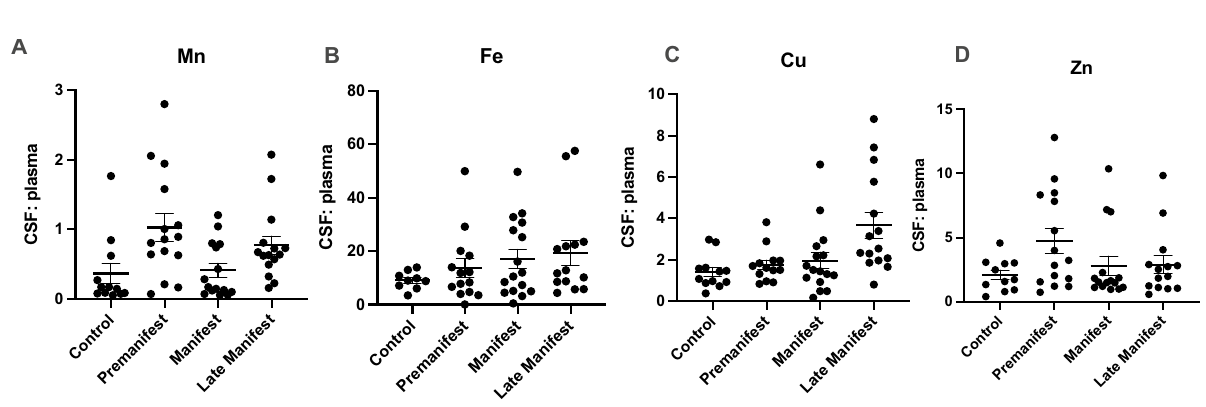
Figure 2. Plasma ( A ) manganese (Mn), ( B ) iron (Fe), ( C ) copper (Cu), ( D ) zinc (Zn) metal levels with the ratio of plasma ( E ) Cu:Zn and ( F ) Fe:Zn between control and HD participants analyzed using 1-way ANOVA with post-hoc testing after determination of significant (p < 0.05) main effects. Data are shown as individual data points with the mean ± sem.